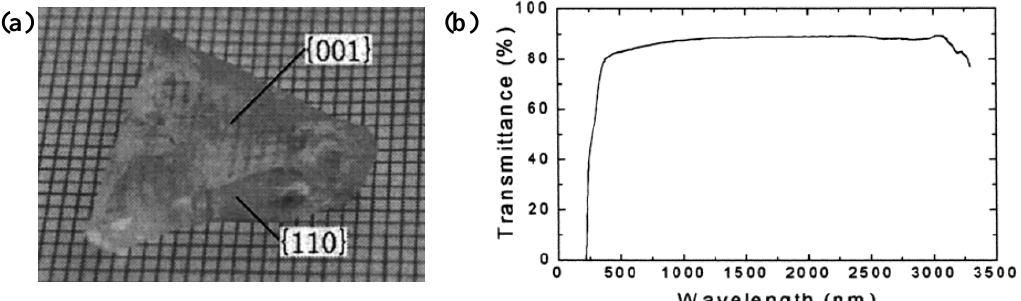
Figure 19. ( a ) Bottom of the as-grown β -Zn 3 BPO 7 crystal with size up to 43 mm × 43 mm × 12 mm; ( b ) transmittance spectrum of β -Zn 3 BPO 7 . Reprinted with permission from Ref. [136], Copyright (2002) American Chemical Society.